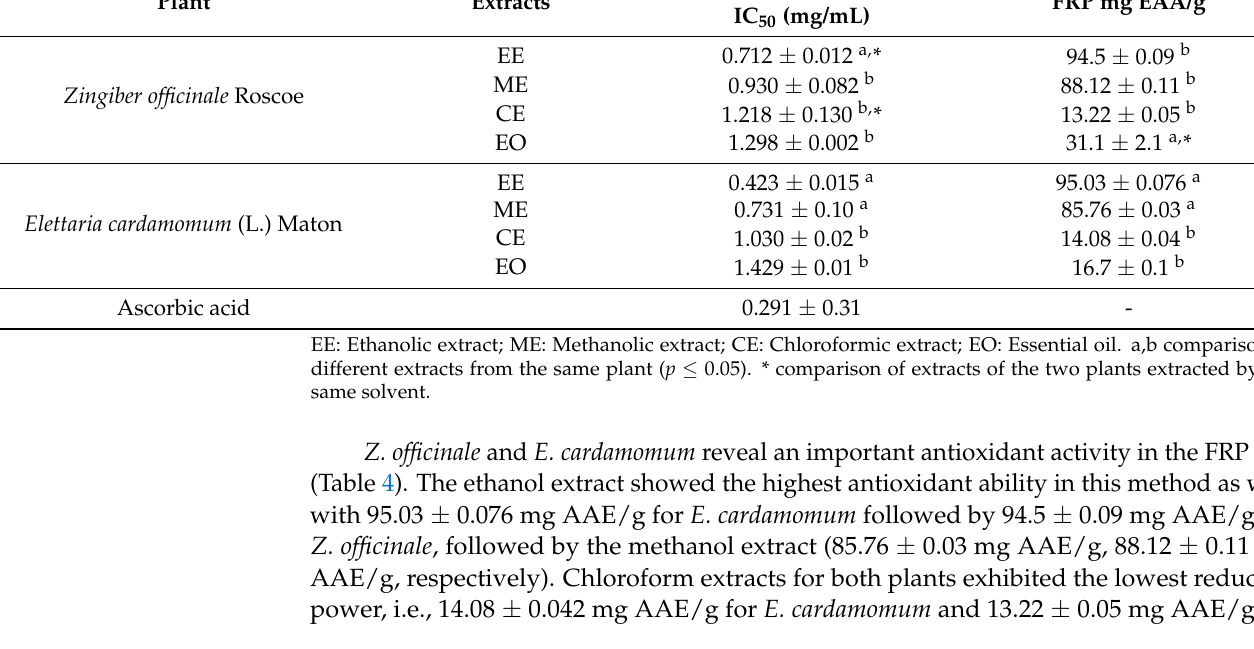
Table 5. Antioxidant activity of Zingiber officinale Roscoe and Eletteria cardamonum extracts and oils.